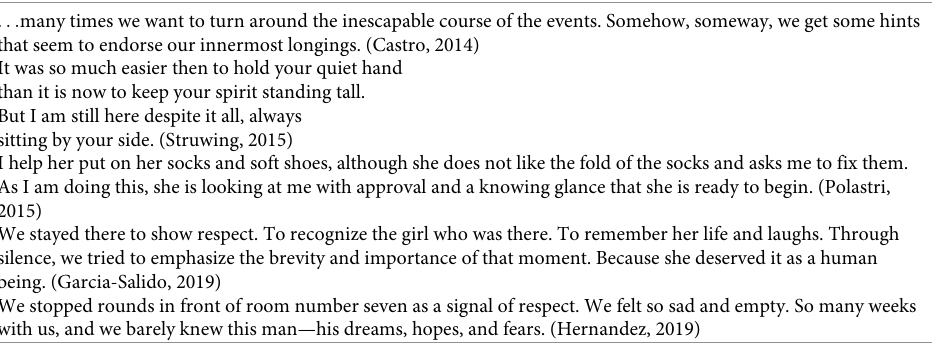
Table 4. Quotation for the sub-theme 3: Emotional